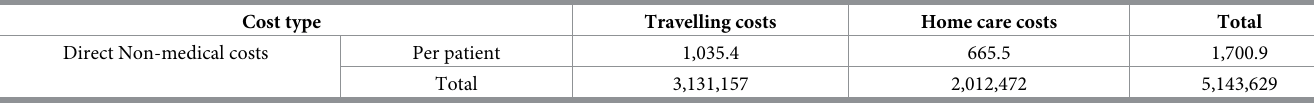
Table 3. The direct non-medical costs due to oral cancer in Iran in 2014.